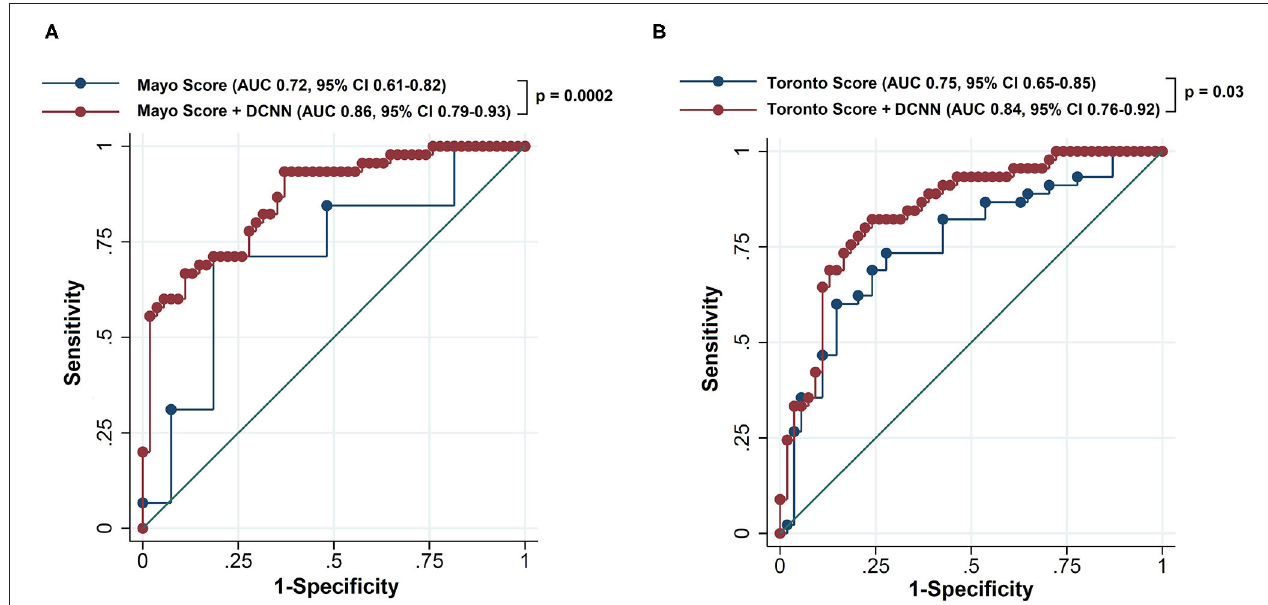
FIGURE 2 | Receiver operating characteristics curve of the reference scoring system and new model combining the reference scoring system and deep convolutional neural network-based probability to predict positive genotype in patients with hypertrophic cardiomyopathy. The reference scoring system was the Mayo score in (A) and the Toronto score in (B) . The dots represent different threshold levels. DCNN, deep convoluted neural network; AUC, area under the receiver operating characteristic curve; CI, confidence interval.